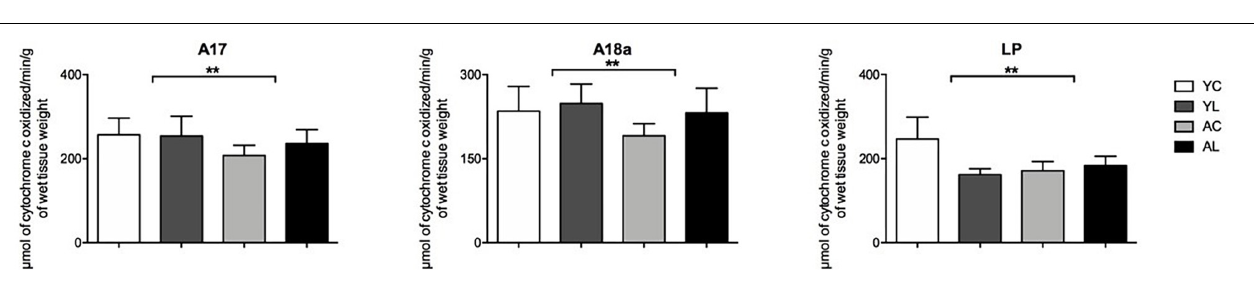
FIGURE 6 | Visual system. Significant CCO activity group differences in the A17, A18a, and LP in rats from young laser (YL; n = 5), young control (YC; n = 7), aged laser (AL; n = 6) and aged control (AC; n = 6) groups ( p < 0.05; ANCOVA). (**) One main effect in the A17, A18a, and LP. See text for